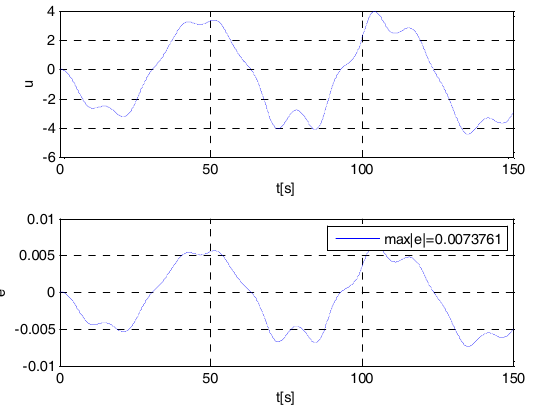
Figure 39. Time histories of u , e for a = 10.